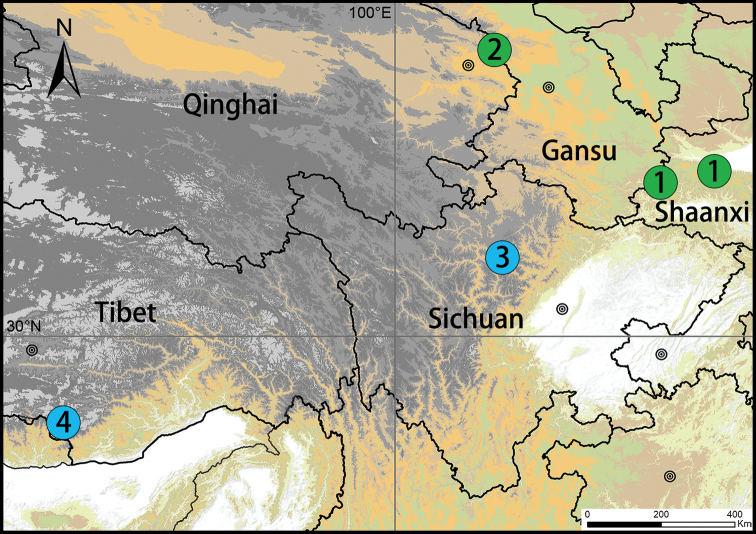
Distribution records of Ectatosticta species from China. 1E.
davidi2E.
deltshevi3E.
wukong sp. nov. 4E.
xuanzang sp. nov.